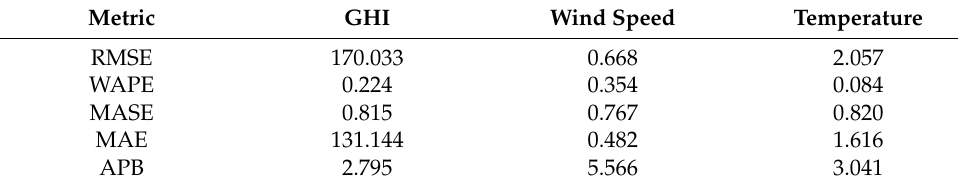
Table 5. Evaluation of weather forecasting.